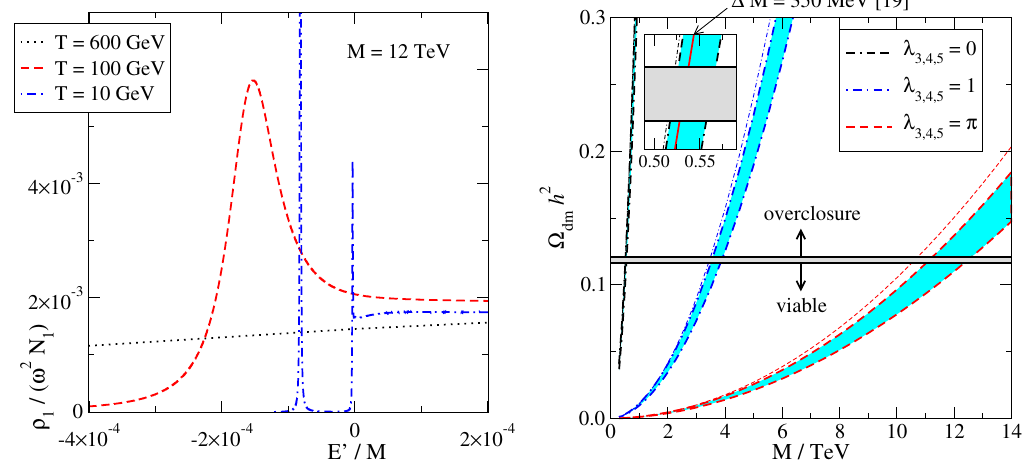
Figure 6 . Left: the spectral function (cid:26) for M = 12 TeV very close to threshold. A rapid 1 broadening and merging of bound states can be observed as the temperature increases (the right- most peak is itself resolved into several peaks at lower temperatures). Right: the dark matter relic density, as a function of M /TeV, for various quartic couplings. Thin lines indicate the tree- level result; thick lines the full result including thermal Sommerfeld and Salpeter corrections and interaction rates. The error estimates of (cid:12)gure 4 lead to modi(cid:12)cations of the order of the thick line width, whereas the large uncertainties shown originate from varying the mass splitting in (cid:12) the range (cid:1) M = (0 : : : 10 (cid:0) 3 ) M . The horizontal line represents the observed value (cid:10) h 2 = (cid:12) dm obs 0 : 1186(20)